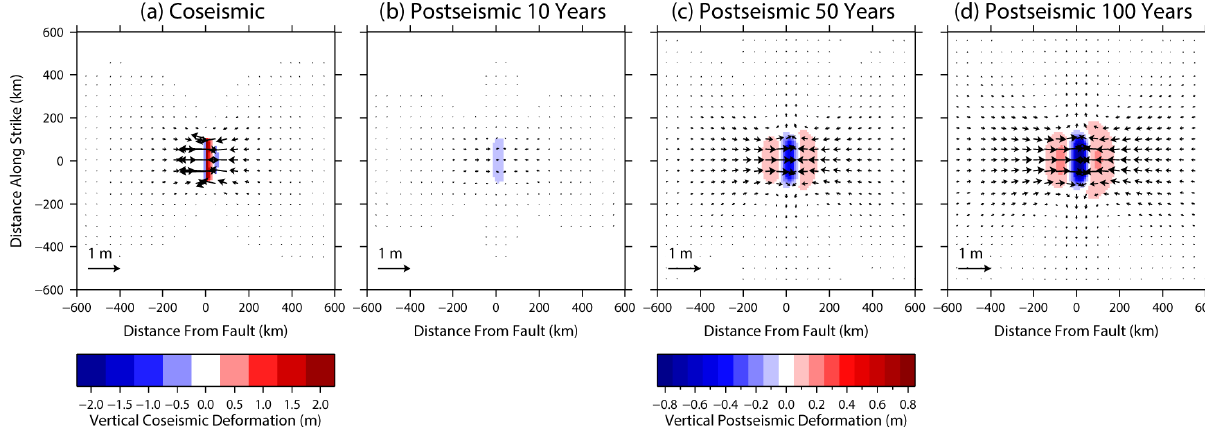
Figure B2. As for Fig. B1 but for a 30 ◦ dipping reverse fault. Note the different colour scales for coseismic and post-seismic displacement.